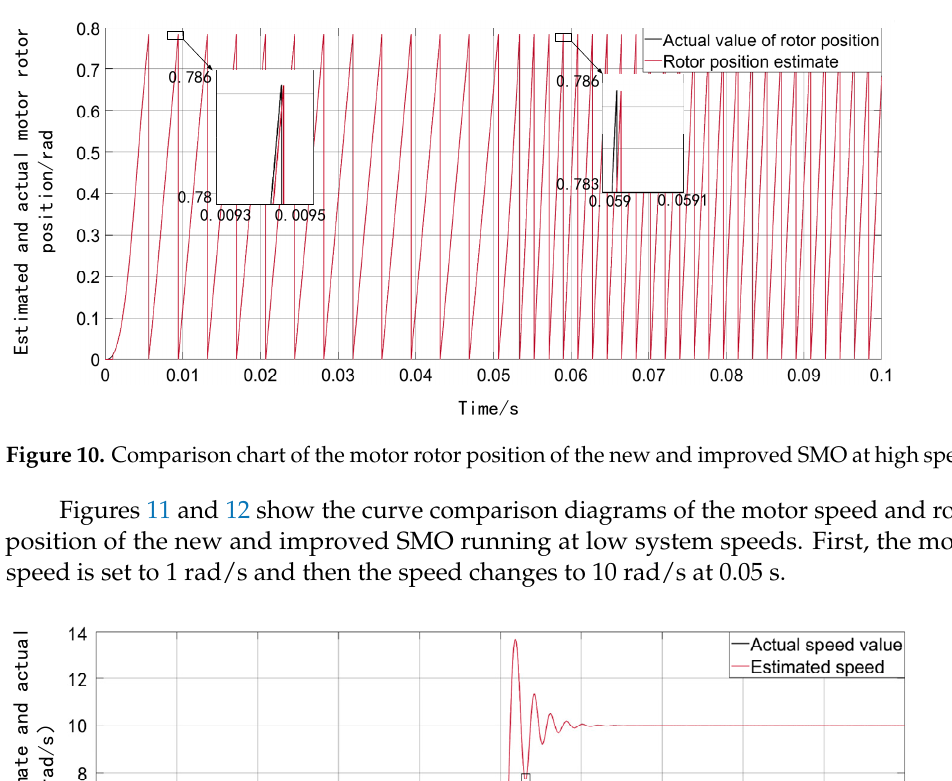
Figure 10. Comparison chart of the motor rotor position of the new and improved SMO at high speed.